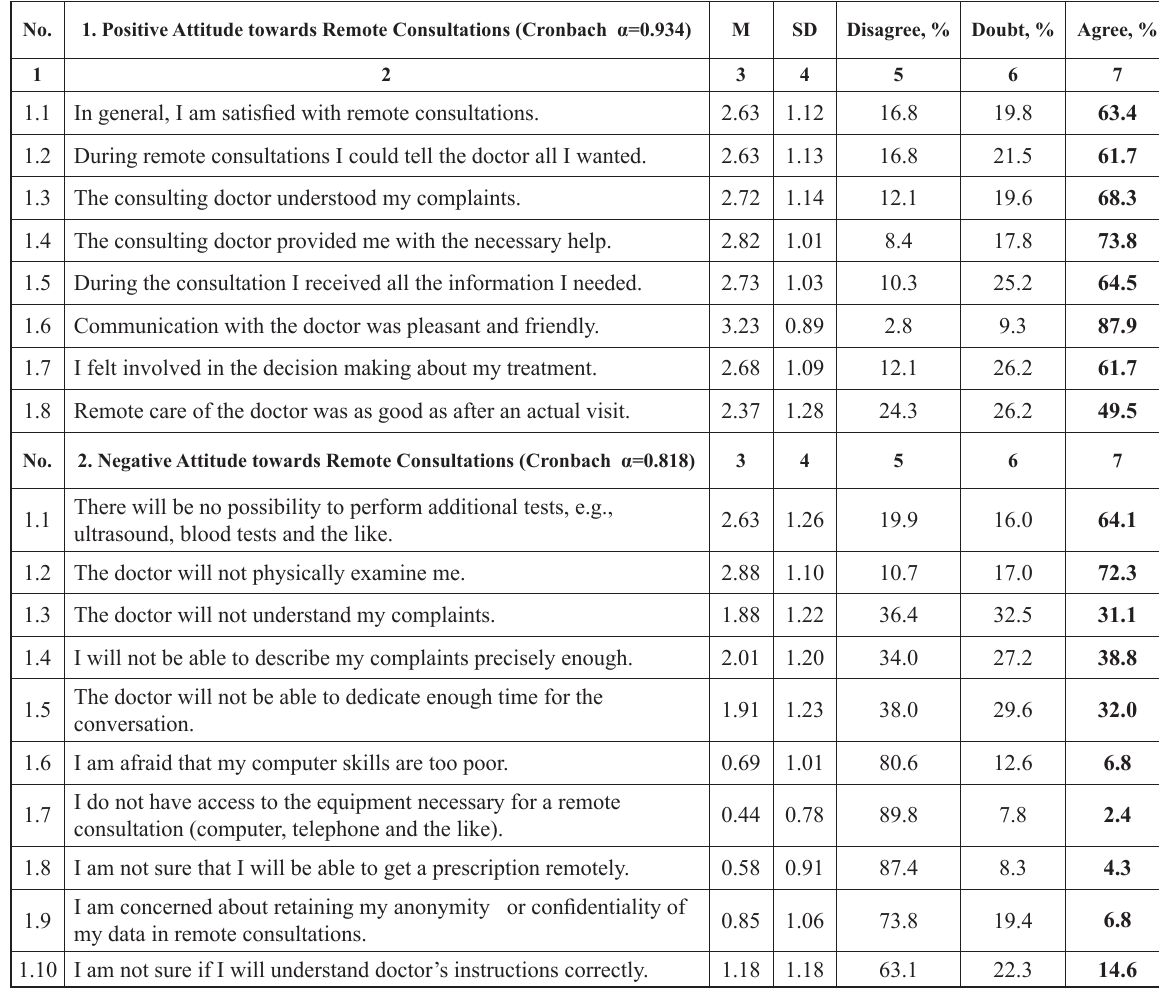
Table 4. Rating of Agreement of Patients with Chronic Rheumatic Diseases with Positive and Negative Attitude towards Remote Consultations of a Rheumatologist